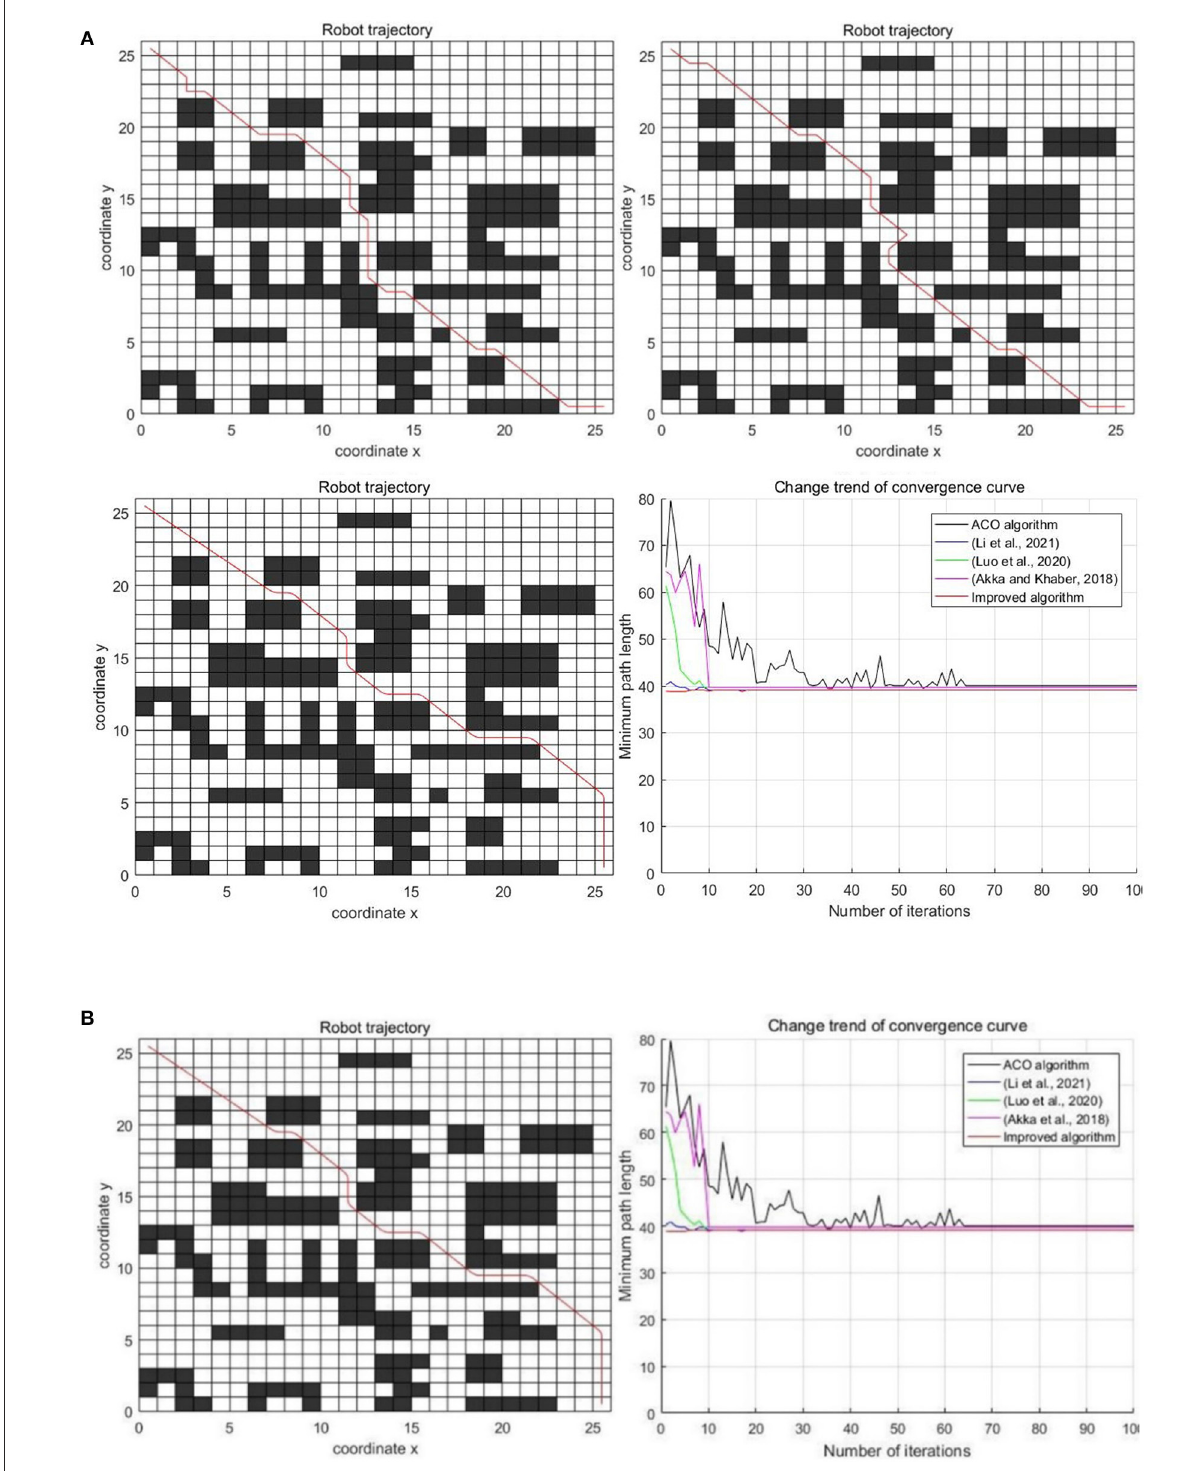
FIGURE11 Experimental results of three algorithms in the partially decentralized obstacle environment. (A) Classic ant colony algorithm, Luo et al. (2020), Li et al. (2021) , and Akka and Khaber (2018). (B) Improved algorithm and comparison of five